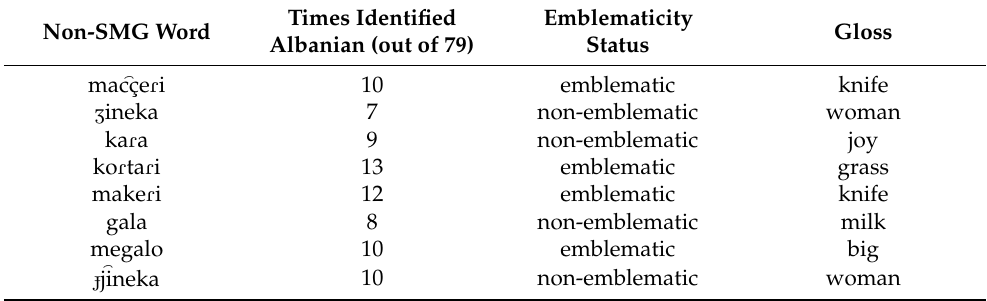
Table 3. Times each non-SMG target was identified as being produced by a talker from Albania.